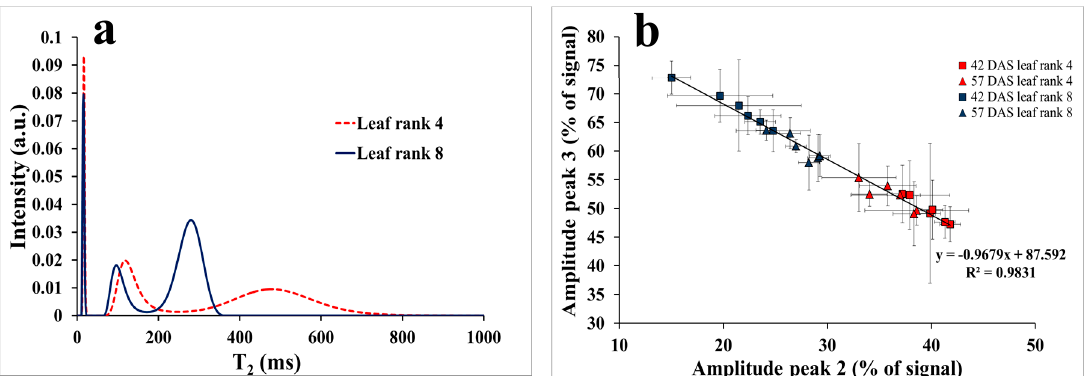
Figure 3. ( a ) T 2 distribution obtained by the MEM method for leaf ranks 8 and 4 of well-watered plants at the second stage; ( b ) correlation between amplitudes of the second and third peaks for LR 4 (red) and LR 8 (bleu) for stages 1 (cube) and 2 (triangle).